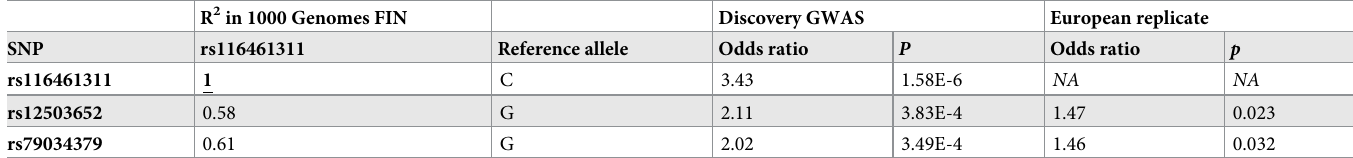
Table 2. Two SNPs that correlated with the top GWAS SNP rs116461311 in SLIT2 showed association with SPTB in European replication data.